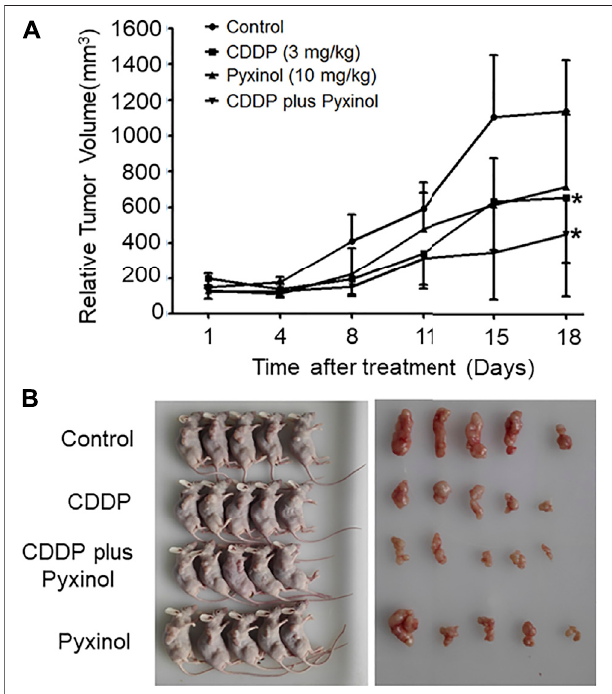
FIGURE7| Effectsofpyxinolonthe invivo anti-tumoractivity ofcisplatin in nude mice. The balb/c nu mice were transplanted with human cervical cancer xenograft tumors (Hela), and treated as indicated. After treatment, the relative tumor volume was measured. (A) : Tumor volume. All data are expressed asmeans ± SD( n (cid:1) 5). *p < 0.05,compared withthecontrolgroup. (B) : Photos of the mice and